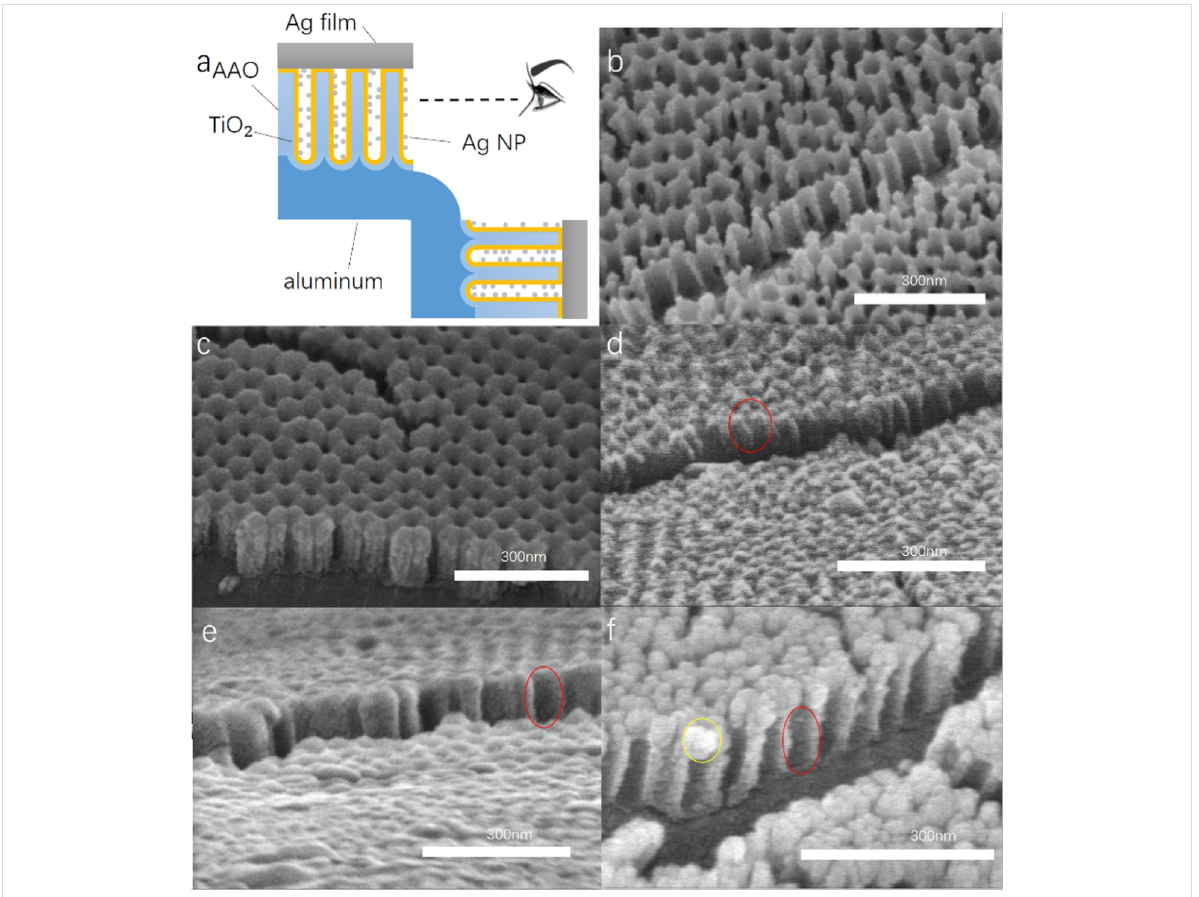
Figure 3: SEM cross section of samples with AAO and Al substrate. (a) Observation sketch, (b) AAO template, (c) TNC, (d) AFT1, (e) AFT2, and (f) AFT3.